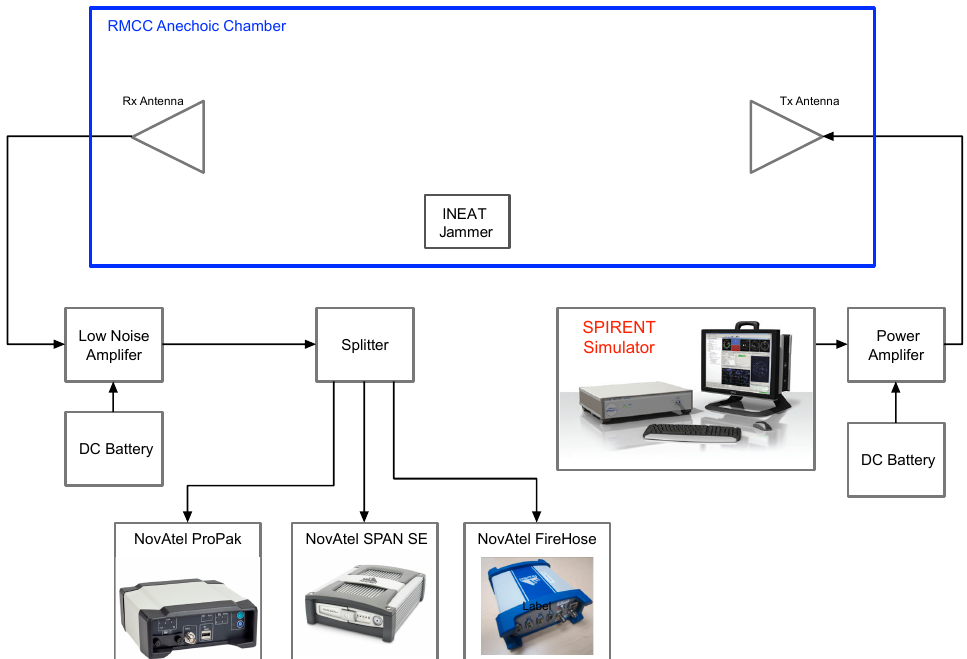
Figure 7. The Complete Real Jamming Experiment Setup.